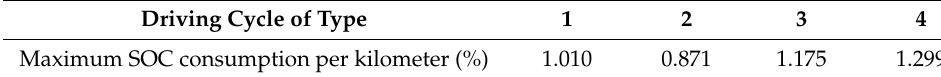
Figure 8. Relationship curve between SOC consumption per kilometer and high efficiency area utilization rate of engine Table 3. Reasonable distribution upper limit value of SOC. under four typical cycles. ( a ) typical cycle 1; ( b ) typical cycle 2; ( c ) typical cycle 3; ( d ) typical cycle 4.